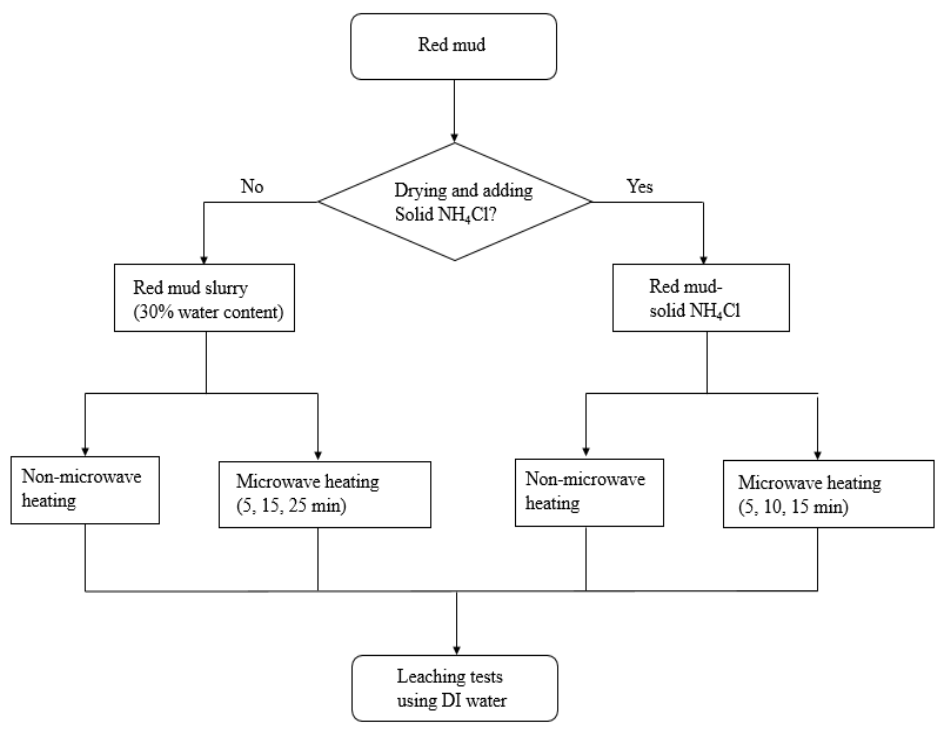
A red mud sample with approximately 30% water content (i.e., red mud slurry) or a mixture of dried red mud and solid NH 4 Cl (i.e., red mud-solid NH 4 Cl) were placed in a heat-resistant ceramic container and heated with microwave ovens for various times (i.e., 5, 10, 15, or 20 min). Schematic of the experimental process is shown in Figure 2.